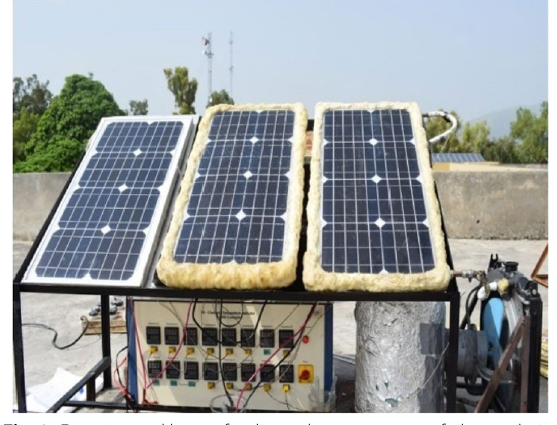
Fig. 3 Experimental layout for thermal management of photovoltaic panels using paraffins